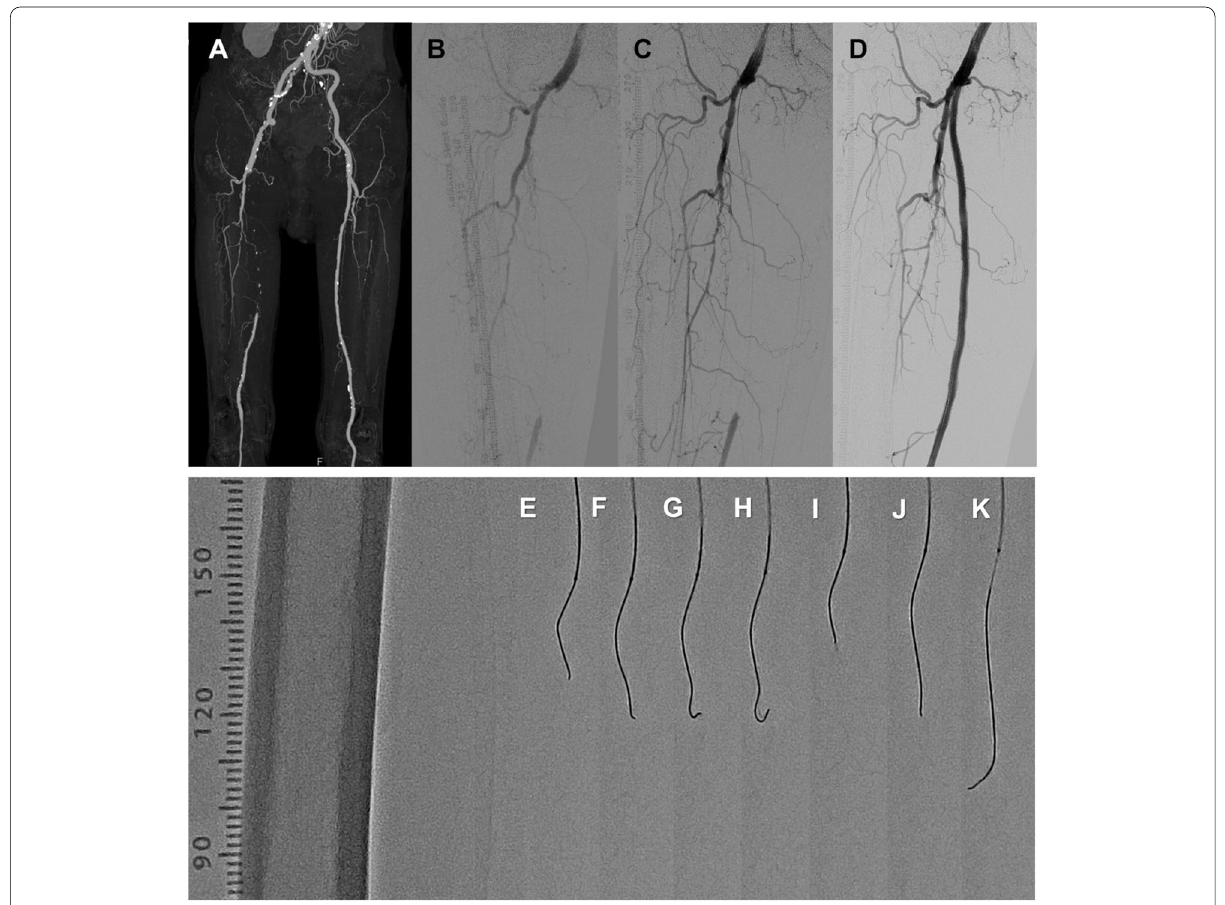
Fig. 3 A representative case of GLIMGLIN. a A computed tomographic angiography revealed a right SFA CTO. Angiography of pre-EVT ( b ), after the wire crossing ( c ), and post EVT ( d ). e-k Shapes of a 0.018-inch Gladius MG ™ during GLIMGLIN. When the first point was bending ( g, h ), the wire pulled back ( i ). The wire was rotated to select a different route for its advancement without bending at the first and second points ( j, k